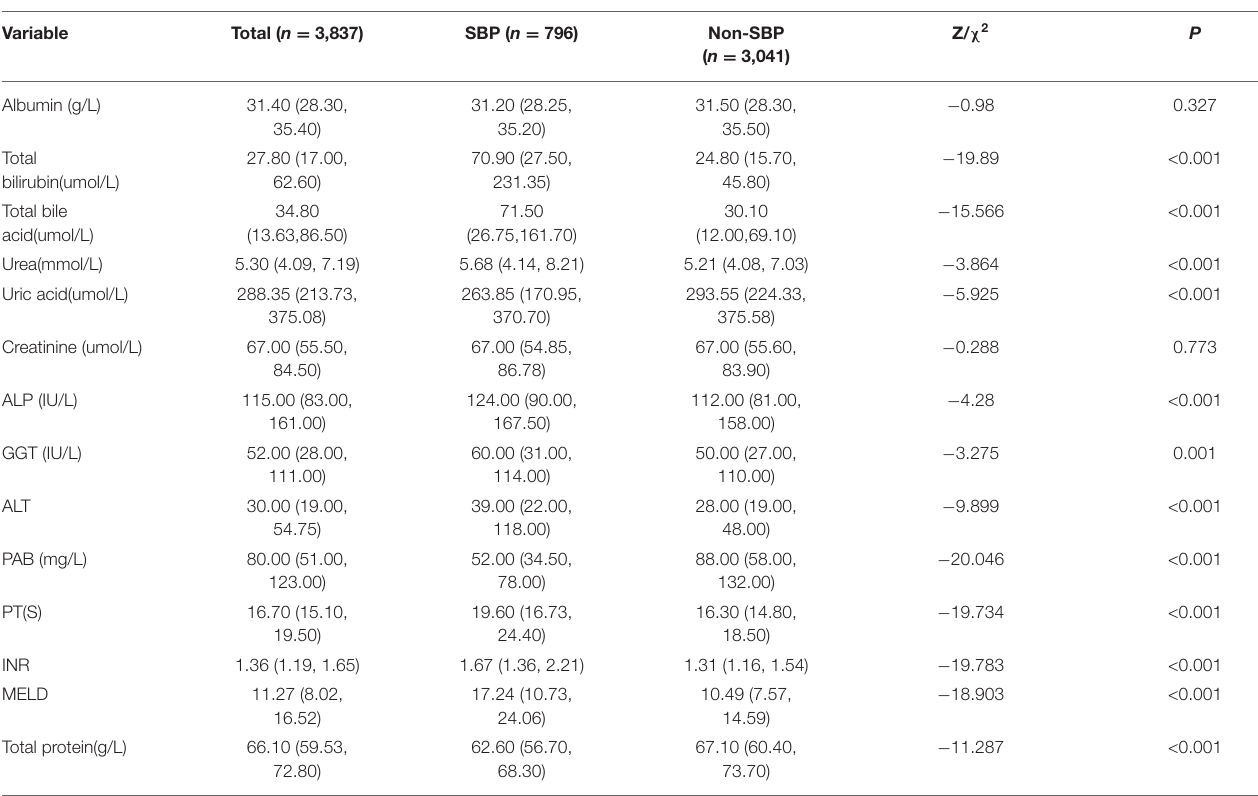
Frontiers in Medicine |